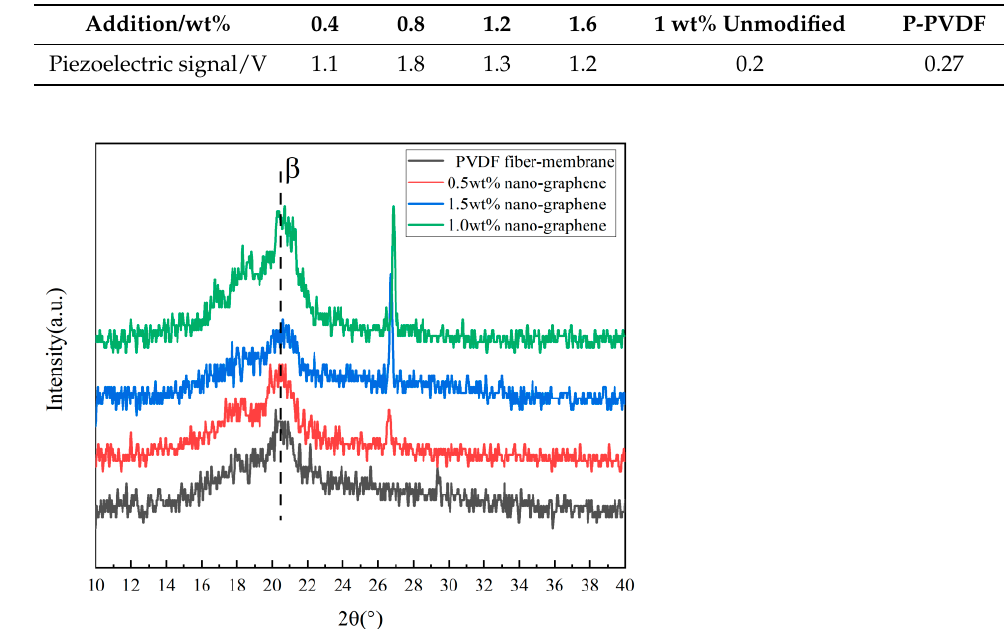
Table 10. Piezoelectric signal of the fiber membrane at different loading of nanographene.